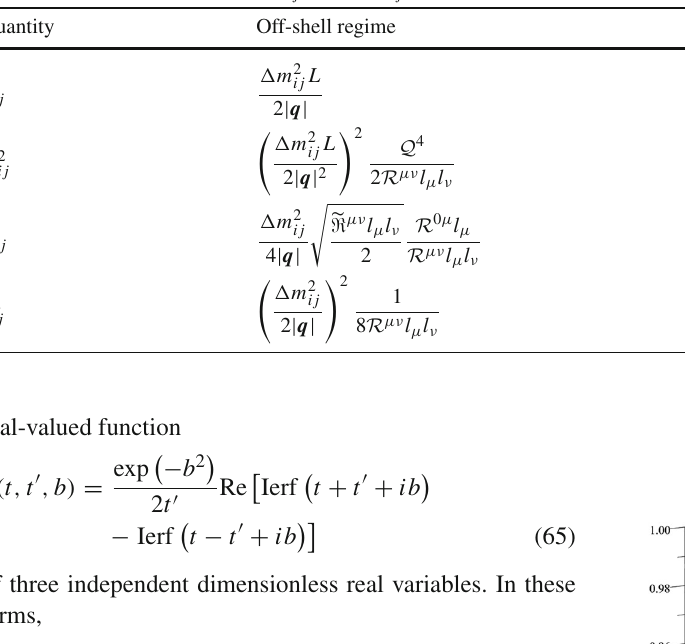
the order of magnitude (OoM) of the corresponding quantity. Evidently, E ν = | q | in the given approximation = m 2 − m 2 . Last column shows ij i j